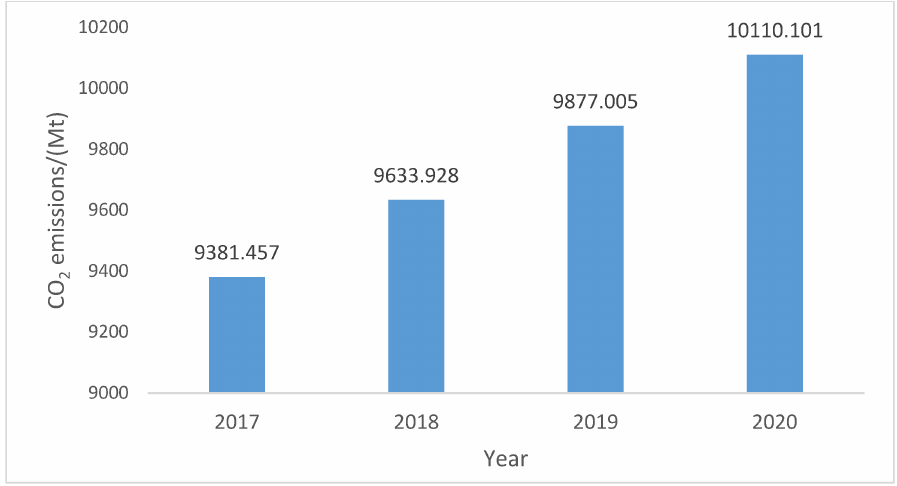
Figure 7. The predicted CO 2 emissions from 2017 to 2020 by